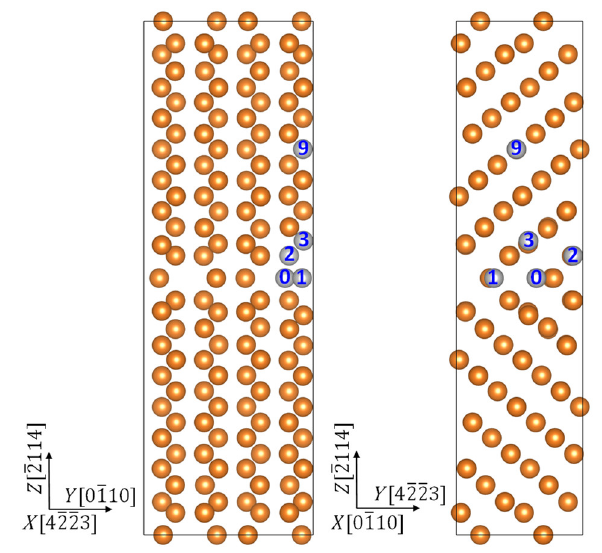
Figure 1. Side views of the supercell used to model the twin boundary segregated with alloying elements. Label “0” denotes the interstitial position at the boundary, and “1”, “2”, “3”, and “9” denote the substitutional positions near the boundary and inside the grain.